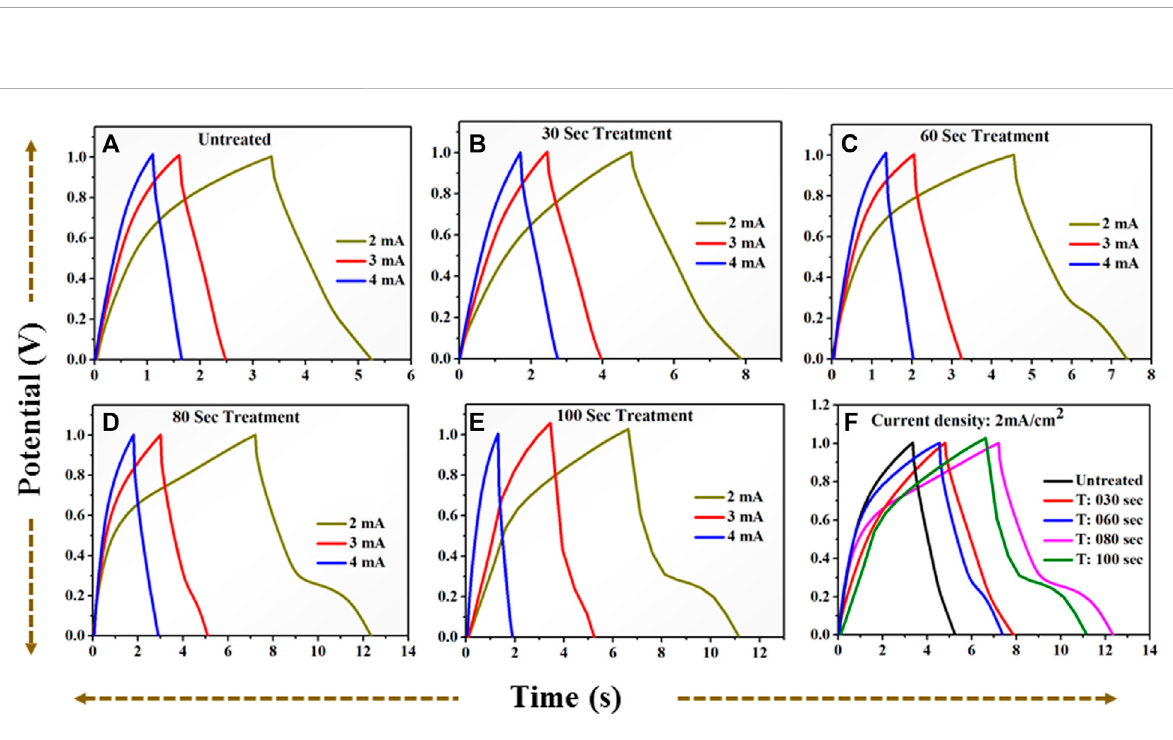
FIGURE 13 GCD pro fi le for positive potential window (A) : for untreated TiO 2 atcurrent (2 – 4) mA. (B) :for 30 s plasma treated TiO 2 at current (2 – 4) mA. (C) : for 60 s plasma treated TiO 2 at current (2 – 4) mA. (D) : for 80 s plasma treated TiO 2 at current (2 – 4) mA. (E) : for 100 s plasma treated TiO 2 at current (2 – 4) mA. (F) : A comparative GCD pro fi le for (A – E) at current 2 mA = 2 mA/cm 2 current